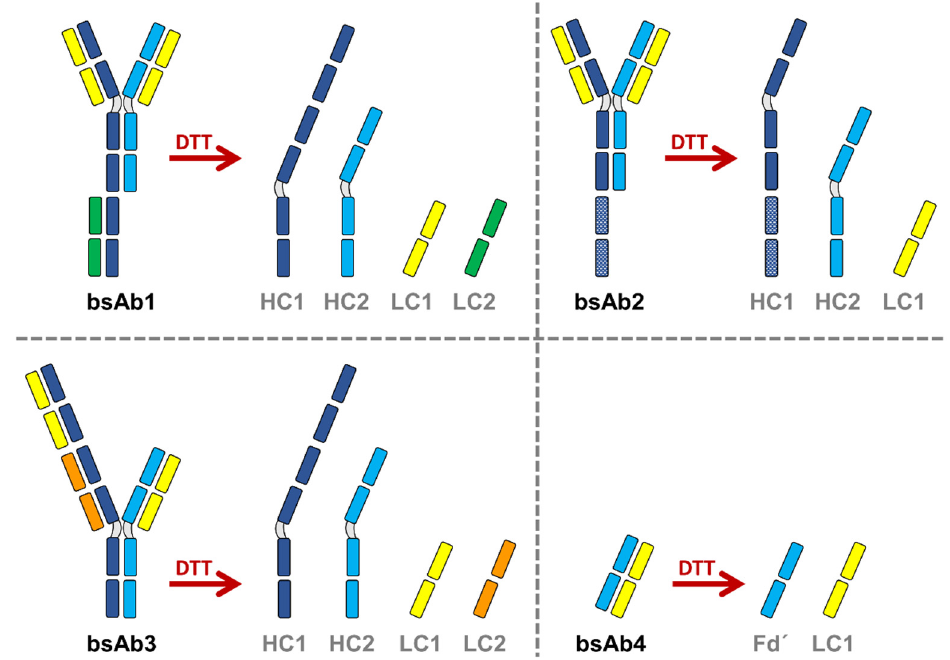
Figure 1. Schematics of the different bispecific antibodies (bsAbs) with the corresponding subunits resulting from the chemical reduction performed with DL-dithiothreitol (DTT). HC and LC stand for heavy chain and light chain, respectively.